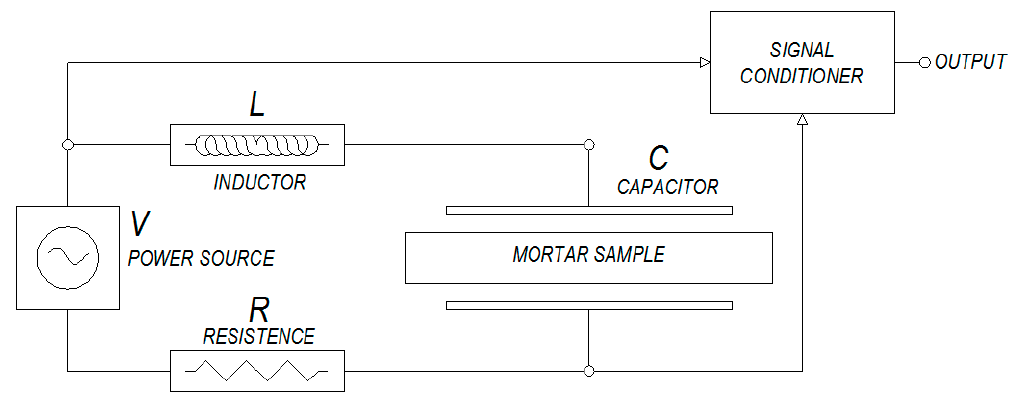
Figure 1. Capacitive sensor scheme.